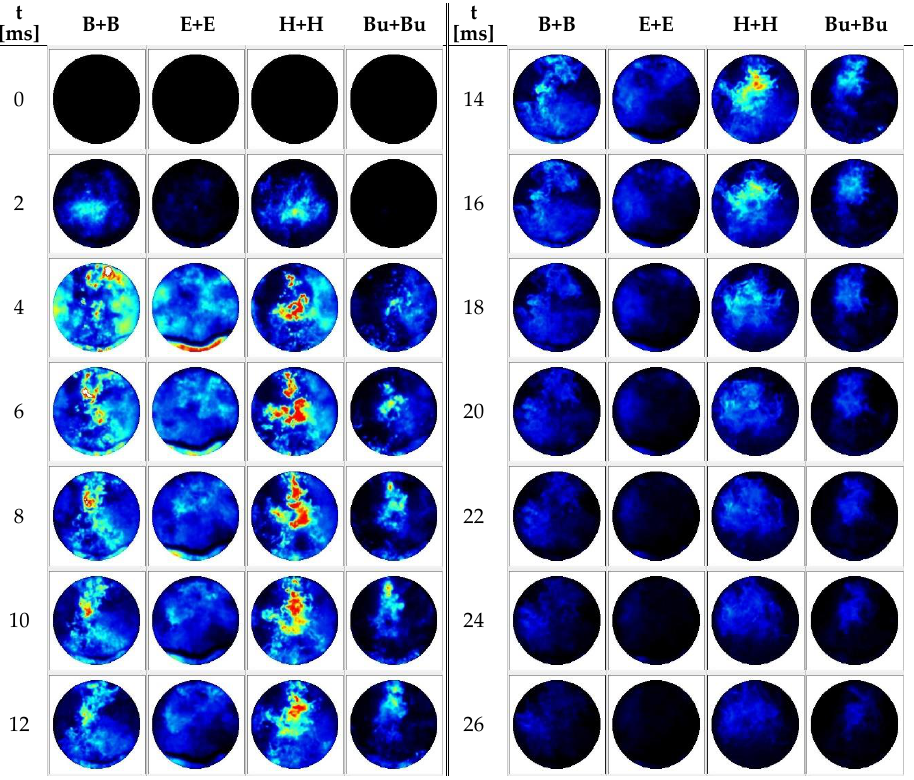
Figure 12. The flame development process recorded during optical experimental tests for single fuel type combustion configurations.